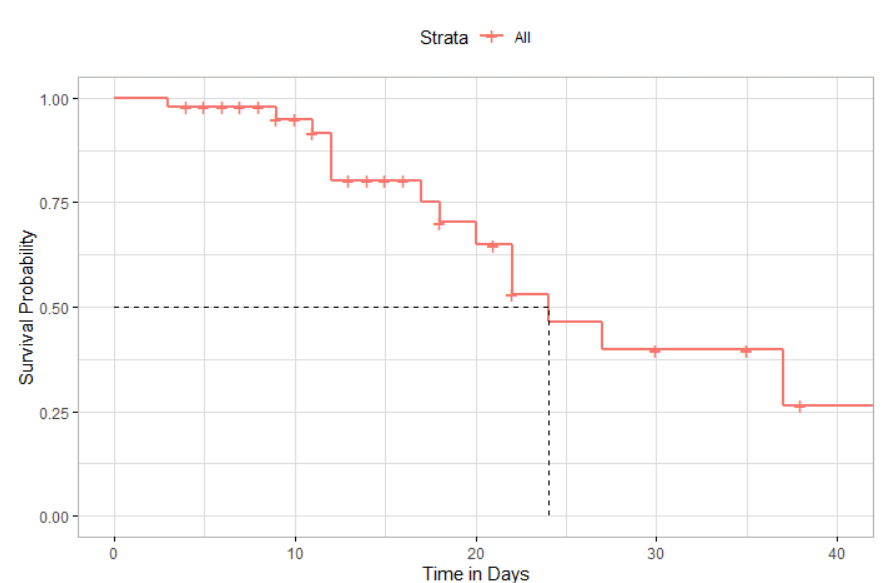
Figure 8. Kaplan – Meier Curve of survival rate after administration of Tocilizumab. Figure 8. Kaplan–Meier Curve of survival rate after administration of Tocilizumab.